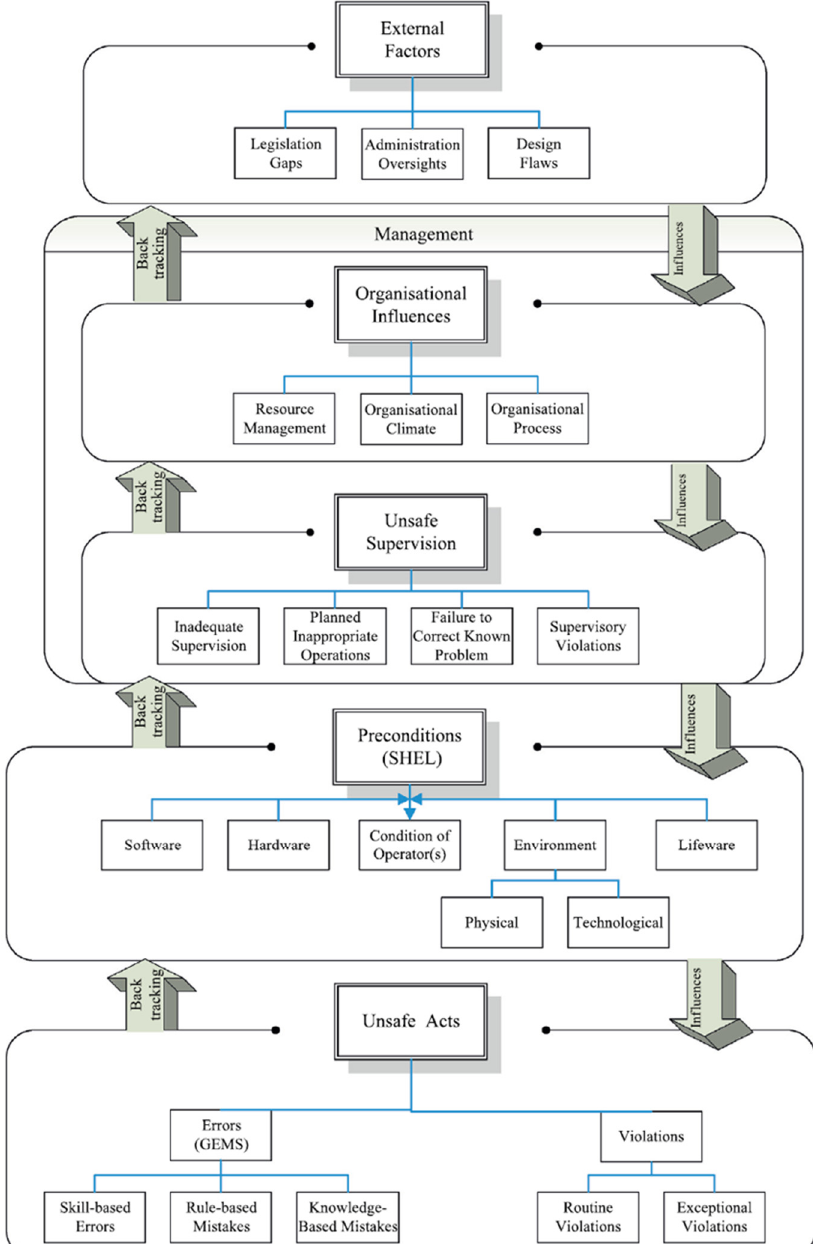
Figure 1. The outline of Human Factors Analysis and Classification System for Maritime Accidents (HFACS–MA) as given in [31].